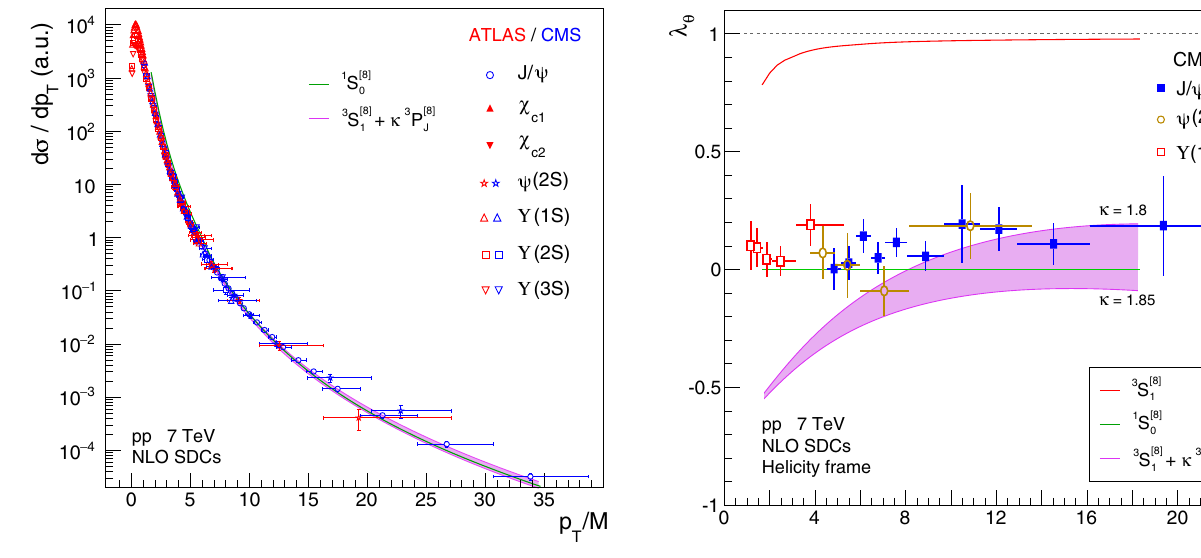
octet (green) and of the 0